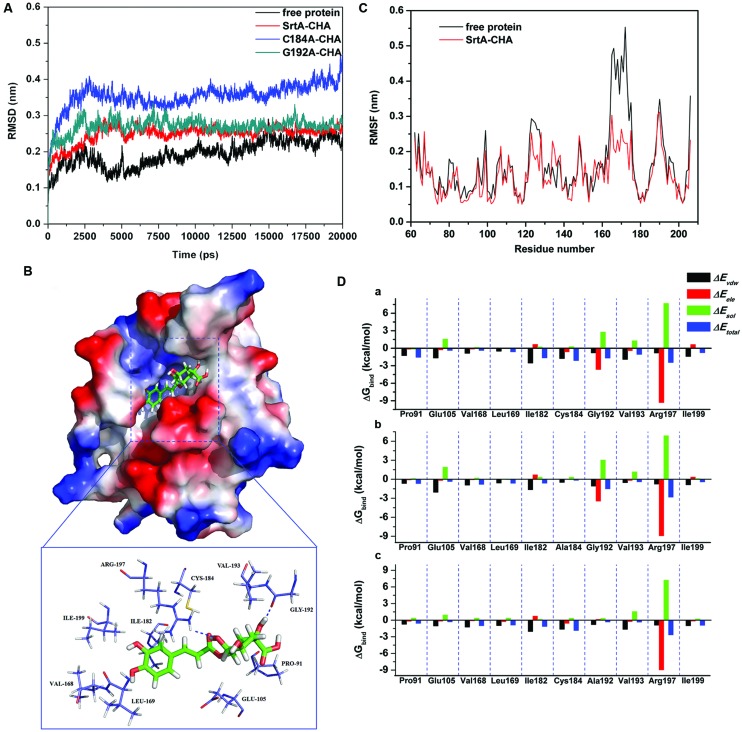
(A) The root-mean-square deviations (RMSDs) of all the atoms of SrtA-CHA complexes with respect to their initial structures as function of time. (B) The predicted binding mode of CHA in SrtA binding pocket obtained from MD simulation. (C) RMSF of residues of the whole protein in SrtA-CHA complex and free SrtA during the last 10-ns simulation time. (D) Decomposition of the binding energy on a per-residue basis in the SrtA-CHA complex (a), C184A-CHA complex (b), and G192A-CHA complex (c).